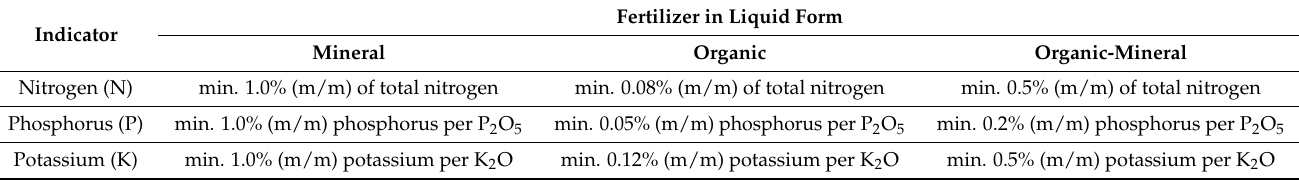
Table 6. Minimum quality requirements to be met by liquid fertilizers (own elaboration based on